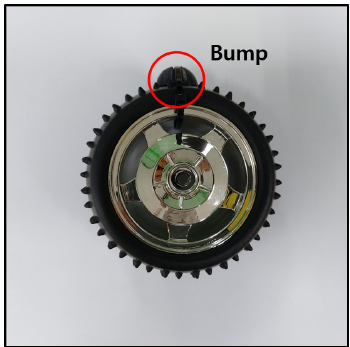
Figure 7. Bump on the